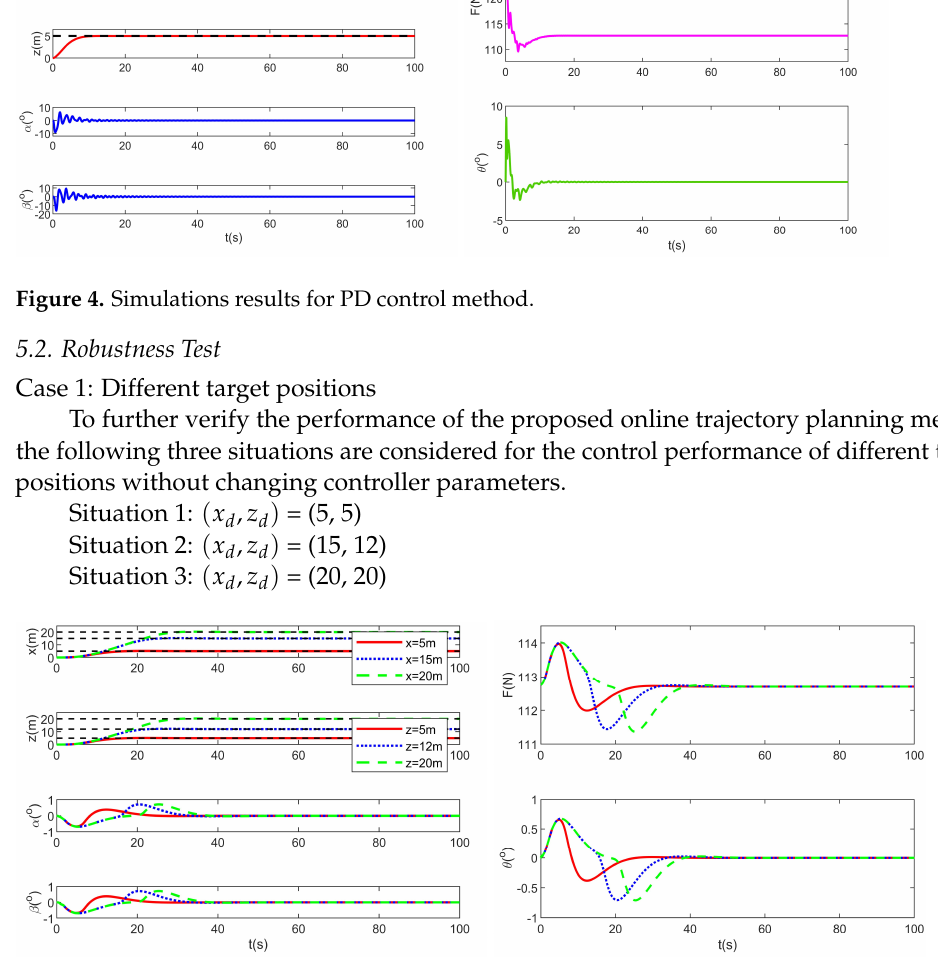
Figure 5. Simulations results for different target